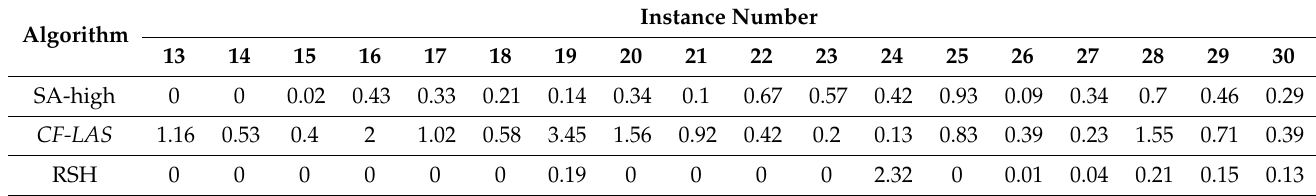
Table 11. Data of the algorithms used for statistical analysis.